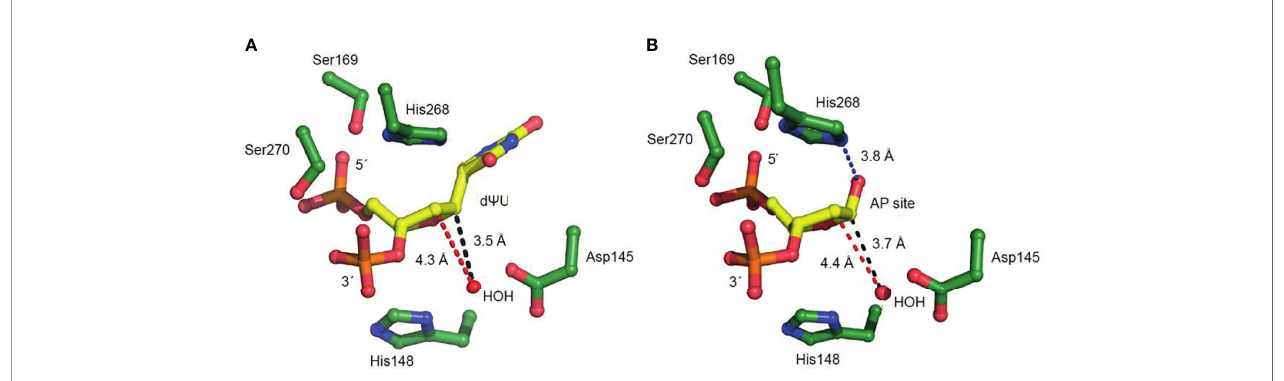
FIGURE 4 | Amino acid residues of hUNG active site region positioned to participate in uracil excision and uracil-DNA incision. These enlarged views in which 2´- deoxyuridine is replaced with (A) 2´-deoxypseudouridine (d Y U) or (B) an AP site indicate amino acid residues involved in substrate binding and coordination. The distances between the catalytic water molecule and the site C1´ where it is attached (causing uracil excision) and the site C2´ of proton elimination (causing uracil- DNA incision) are indicated by black and red broken lines, respectively. The His268 NH – C1´O distance in (B) , facilitating proton removal from C2´, is indicated by a blue